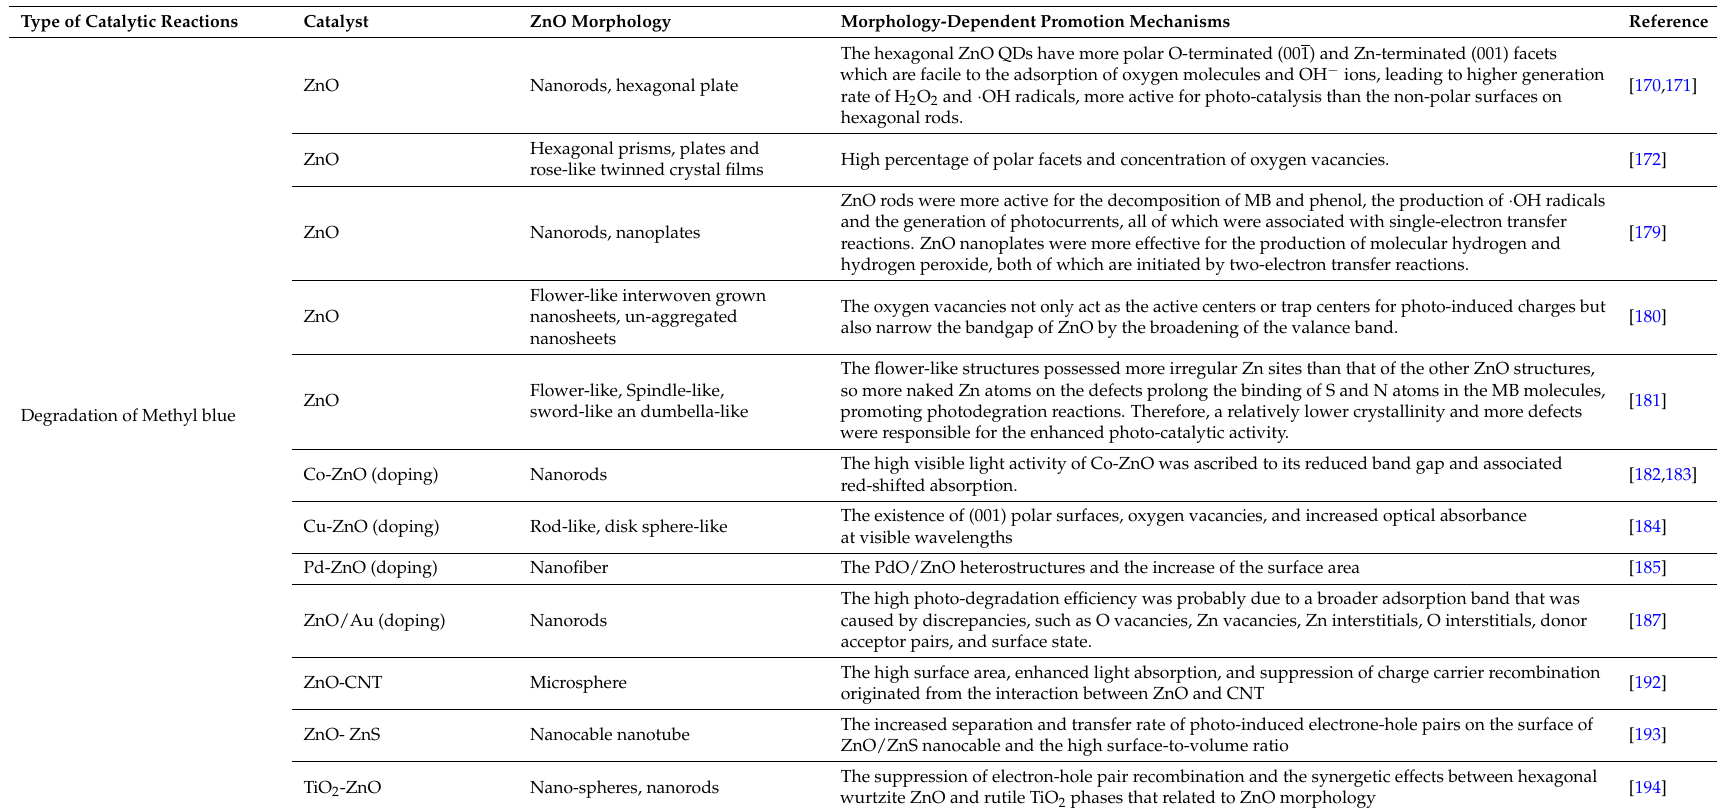
Table 2. The applications of morphology controlled ZnO in the photo-catalytic